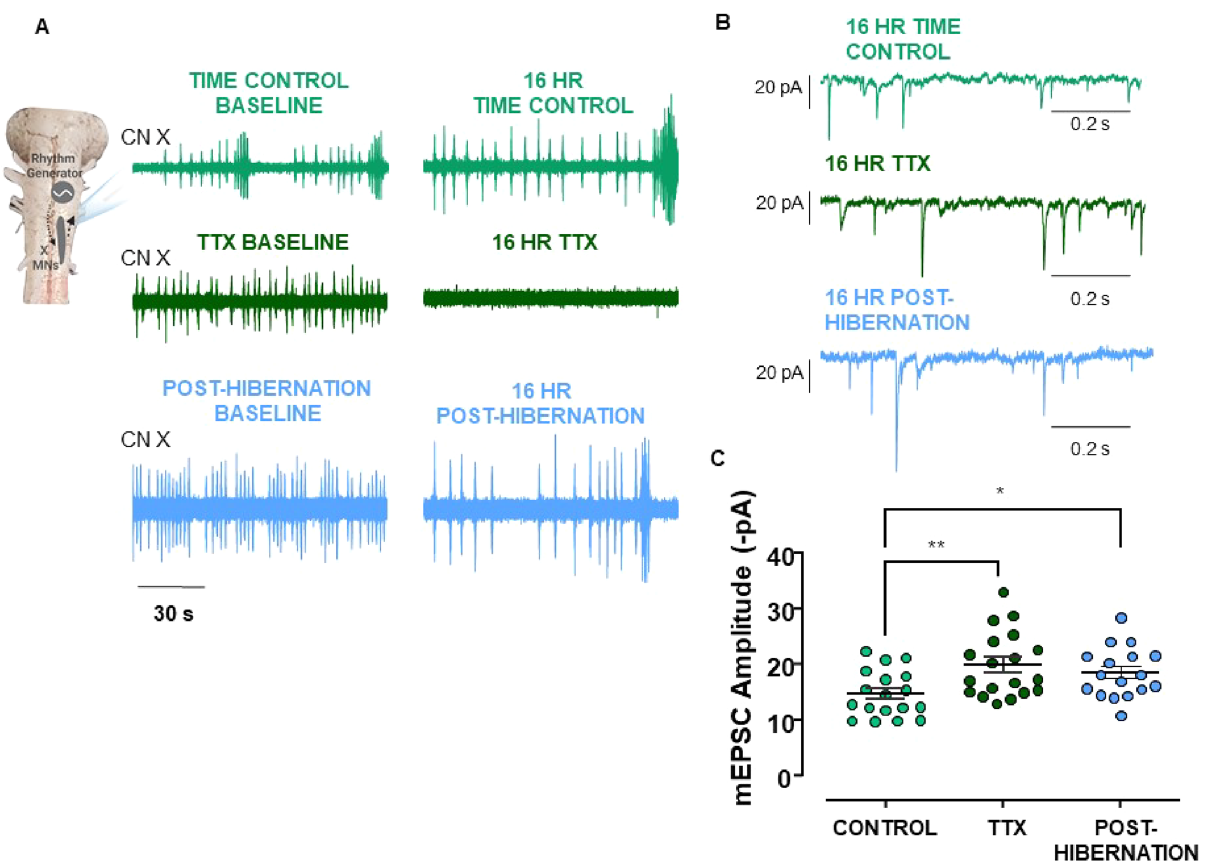
Figure 2. Hibernation and TTX induce increases in mEPSC amplitude to the same extent. ( A ) Example raw extracellular respiratory-related vagal motor signals (CNX) driven by the respiratory rhythm generator, highlighting activity for the entire incubation period. TTX silenced activity in all preparations ( B ) Example mEPSC traces recorded in whole-cell voltage clamp in laryngeal motoneurons in time control, TTX, and following hibernation. ( C ) Mean data showing enhanced mEPSC amplitude following both hibernation and TTX exposure relative to time control (One-way ANOVA, Holm-Sidak Multiple Comparisons Test, control vs. TTX, p = 0.004, control vs. post-hibernation, p = 0.0139, TTX vs. post-hibernation, p = 0.4405). Circles represent cell-averaged mEPSCs for each neuron. Error bars are S.E.M. Horizontal line represents the mean. Control (n = 18 from 5 animals), TTX (n = 19 from 5 animals), post-hibernation (n = 17 from 4 animals). *p < 0.05, **p <